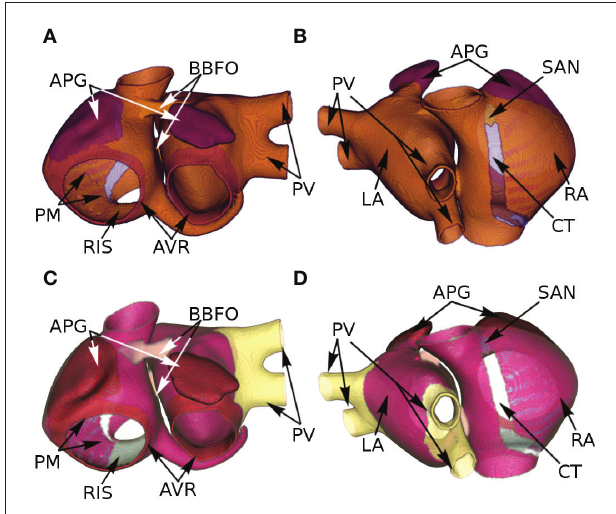
FIGURE 2 | Segmentation of the atria according to AP-based (A,B) and conduction-based (C,D) heterogeneity, as assigned by Tobón et al.